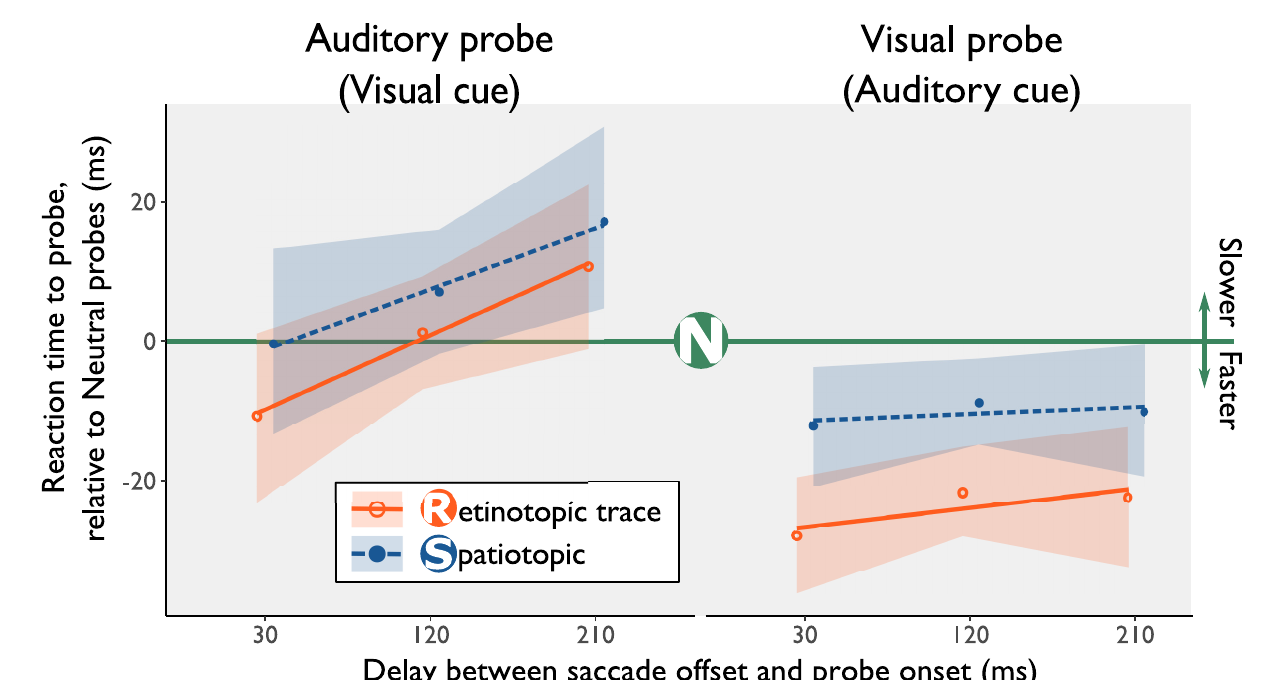
Fig 4. Results from the linear mixed effects model in Experiment 3. The green line represents reaction times to probes shown at the neutral location, all other lines are drawn relative to the neutral condition. The lines represented the fits from the linear mixed models, the points indicate the binned average data, after correcting for online saccade detection. In both the visual and auditory experimental block, probes at the location of the retinotopic trace are reacted to significantly faster. Shaded regions represent bootstrapped 95% CI’s. To reduce visual overlap, the orange and blue line have been offset slightly in the horizontal